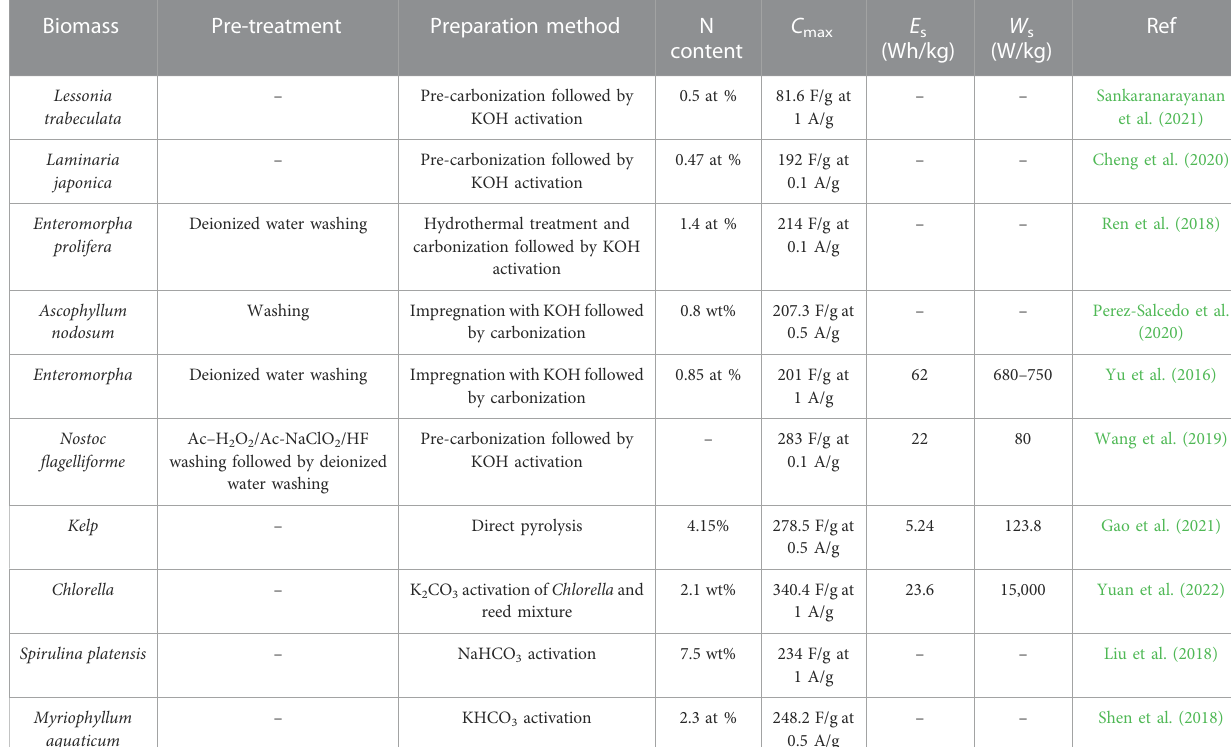
TABLE 4 Algae-based N self-doped biochar applications in